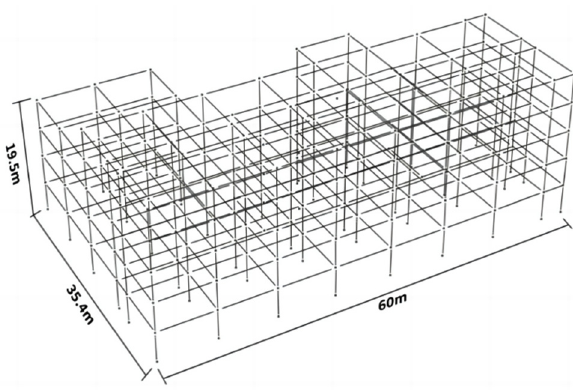
Figure 4. Perform ‐ 3D model of a five ‐ story frame.